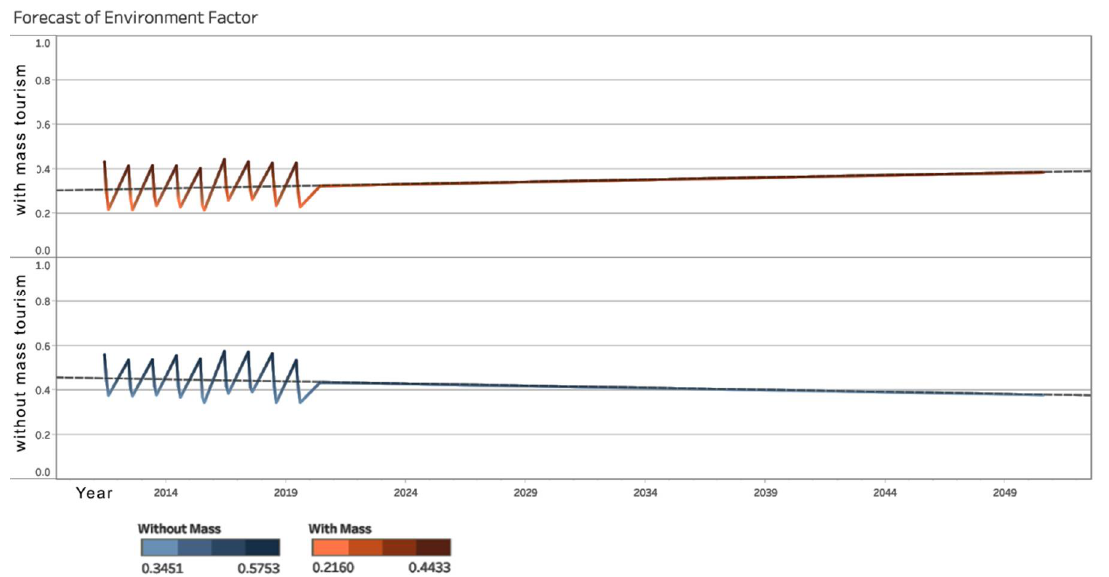
Figure 15. Analysis of environmental factor average indicators for the two scenarios.